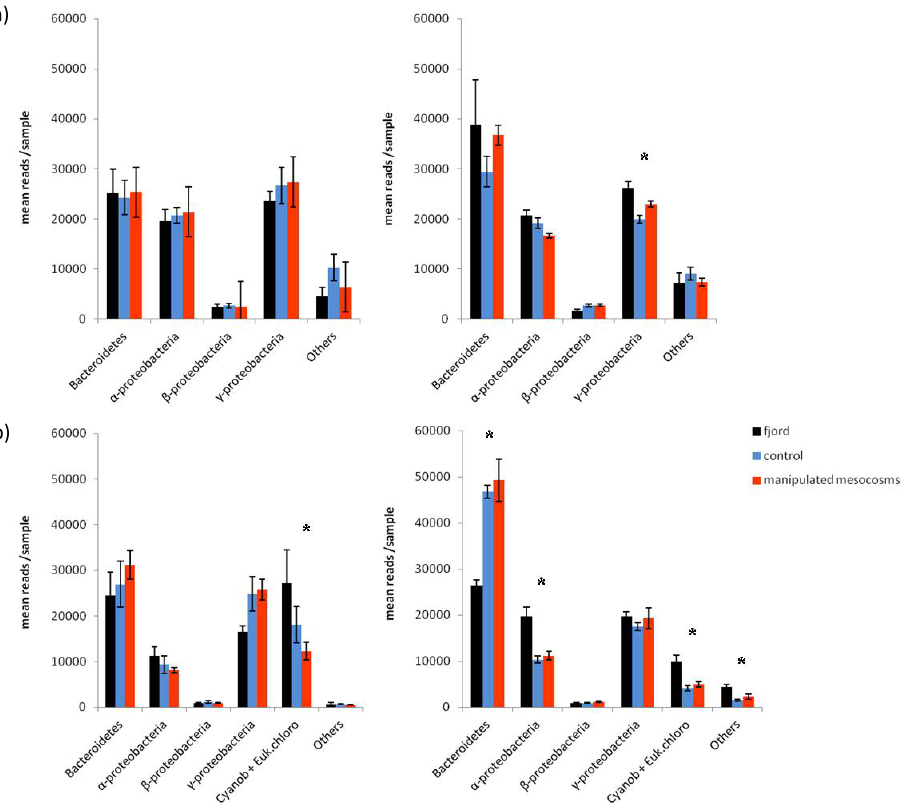
Fig. 3. Mean abundance (+/- SE) of the main phyla of the bacterial community for the fjord (~145 µatm), the control (2 x ~185 µatm) and the manipulated mesocosms (~270, ~685, ~820, ~1050 µatm) of the small (a) and large (b) size fraction pre- (left) and post (right) –nutrient addition. Phyla with significant different p values (< 0.05) as a function of samples origin are marked with a *.